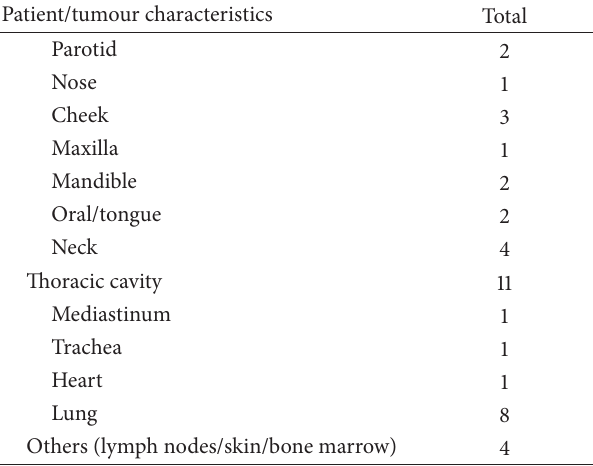
Table 1: Patient and tumour